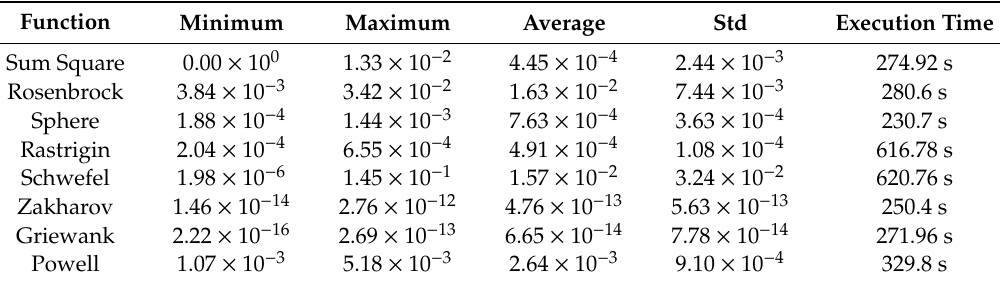
Table 13. Results of the OFHS method applied to benchmark mathematical functions.